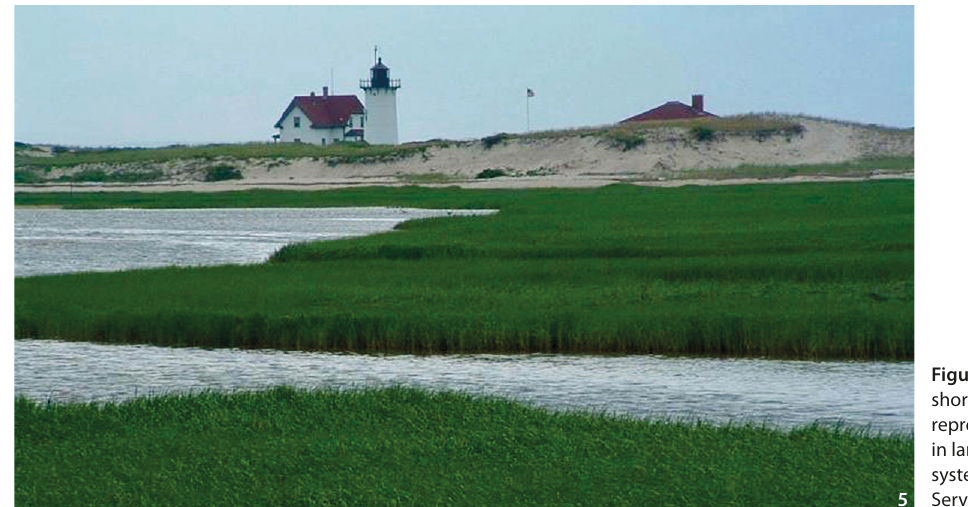
Figure 5 Cape Cod National Sea- shore, a recreational landscape representing one of the first lived- in landscapes in the national park system (Source: National Park Service).